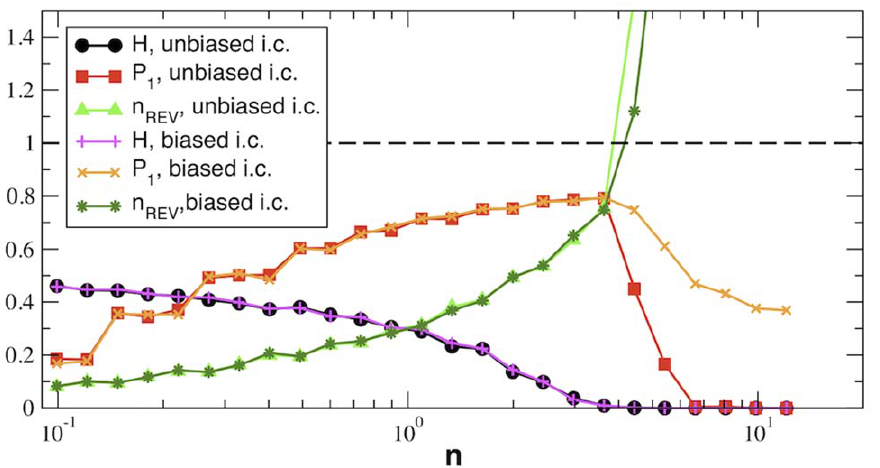
Figure 2. Results for random reaction networks. Average stationary values of H , fraction of asymptotically unidirectional reactions ( P 1 ) and relative number of asymptotically bidirectional reactions n rev ~ N rev = M versus n ~ N = M obtained from (26) (with no prior assumption on reaction reversibility for an ensemble of random reaction networks with NM ~ 10 4 constructed as described in the text. Averages are taken over 200 realizations for each value of n . Unbiased i.c. (initial conditions) refers to steady states of (26) for y i (0) ~ 0 ; biased i.c. instead correspond to y i (0) ~ 5 N for each i . Note the two phases with H w 0 ( n v n c ) and H ~ 0 ( n w n c ) as predicted. The critical point n c coincides within numerical error with the point where N rev ~ 1 . Finally, the phase with H ~ 0 is non-ergodic: different initial conditions lead to different NESS, characterized by different values of P 1 .